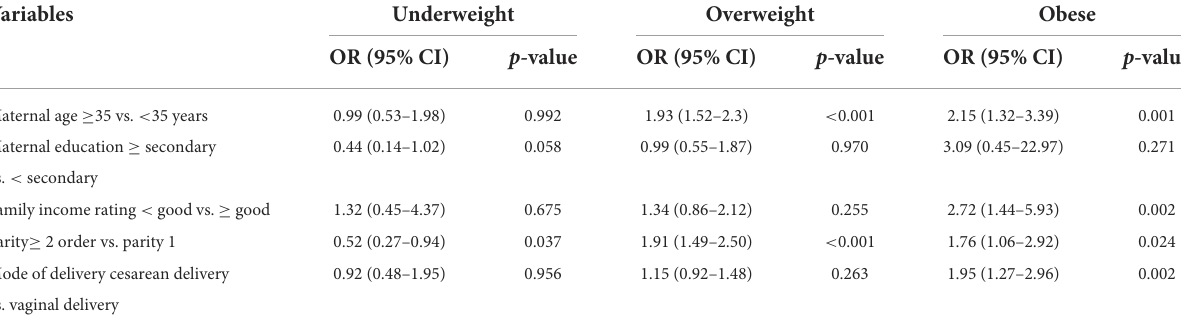
TABLE 2 Factors associated with underweight, overweight and obesity among studied participants in Abu Dhabi, the United Arab Emirates using multinomial logistic analysis. Variables Underweight Overweight